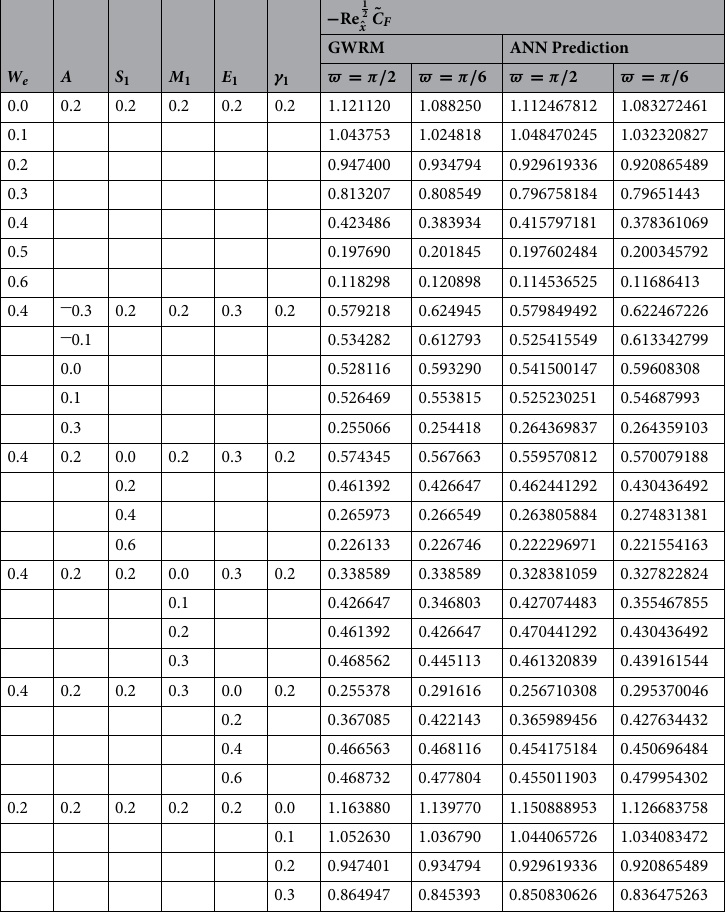
Table 3. Numerical values of skin friction coefficients Re